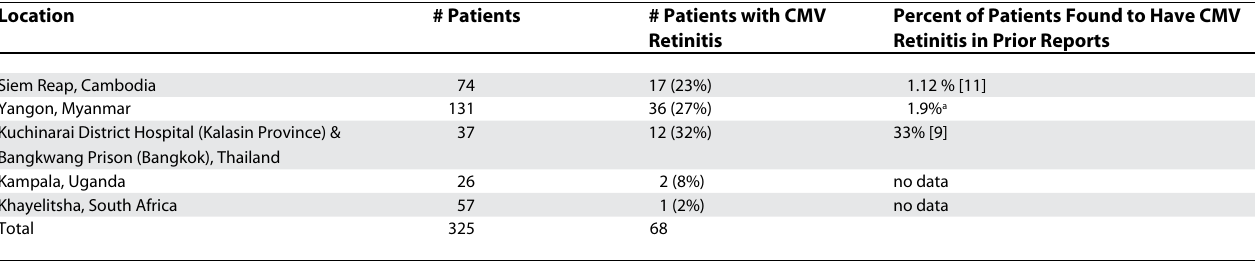
Table 1. CMV Retinitis in Patients with AIDS with CD4 Counts Below 50